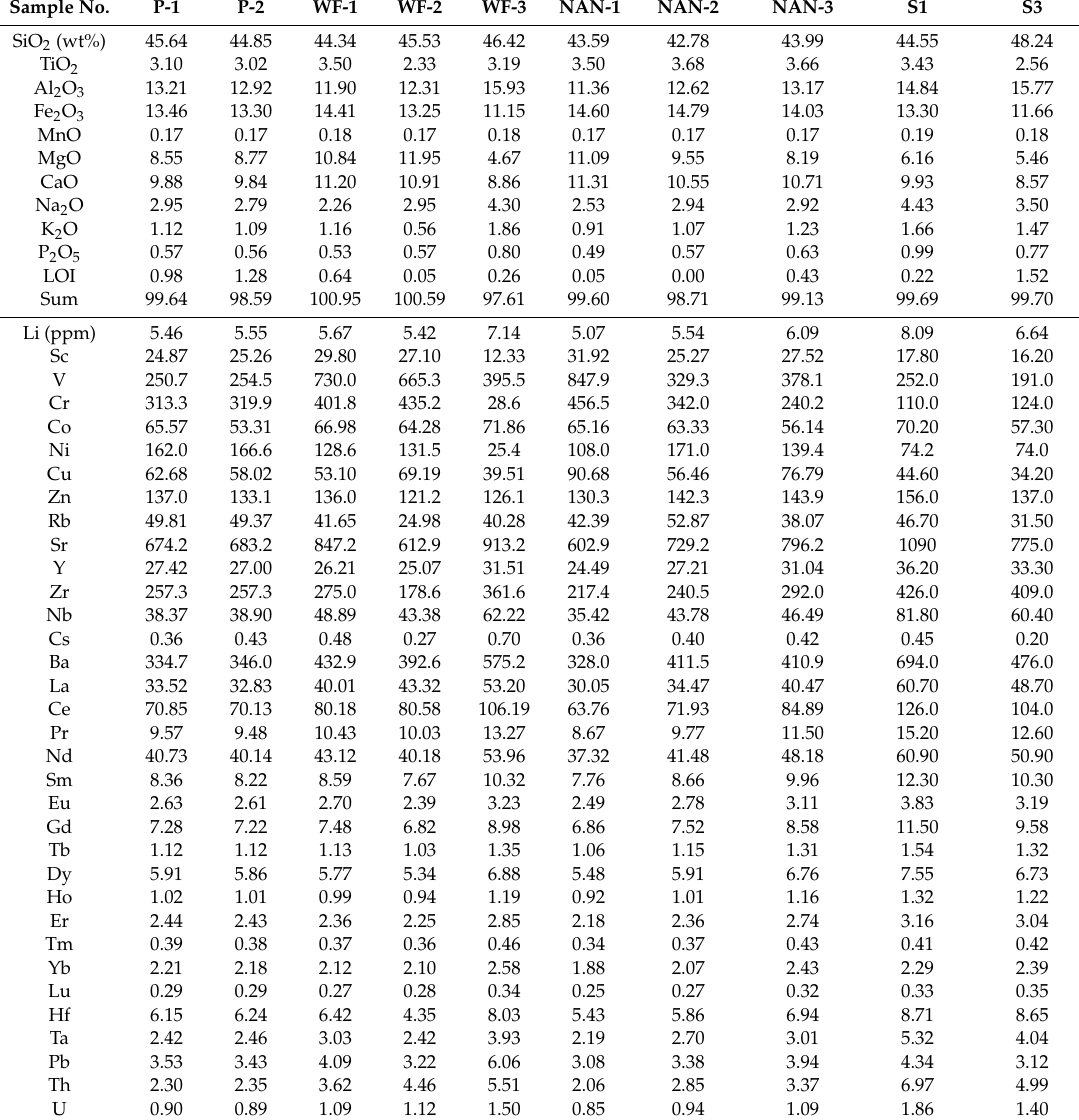
Table 1. Major- and trace-element (ppm) contents of lavas from Pohnpei Island. (LOI—Loss on ignition). Sample